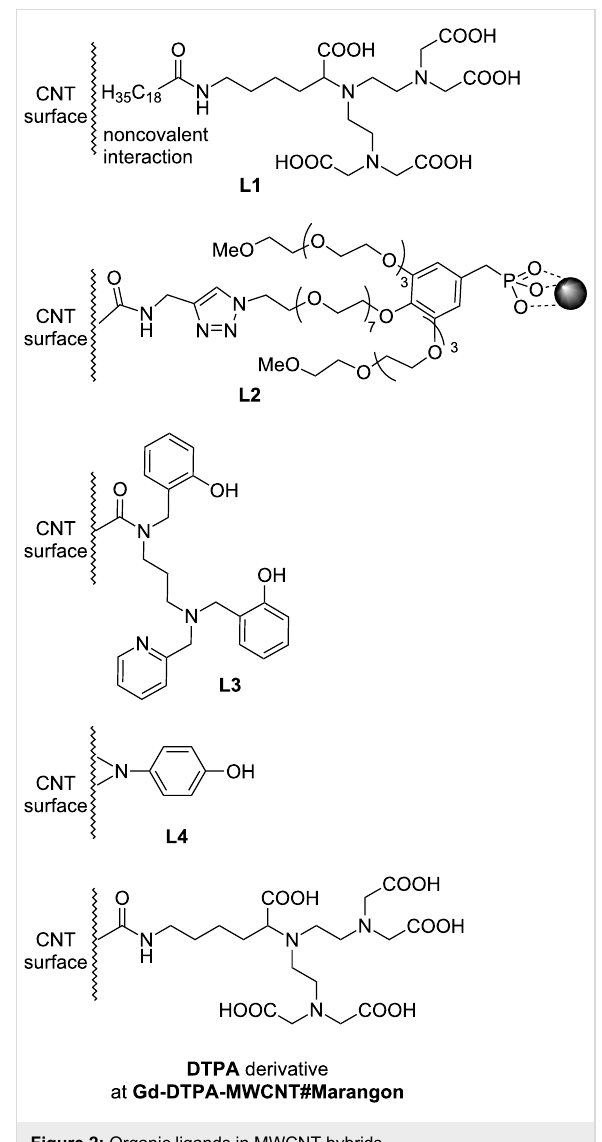
Figure 2: Organic ligands in MWCNT hybrids.